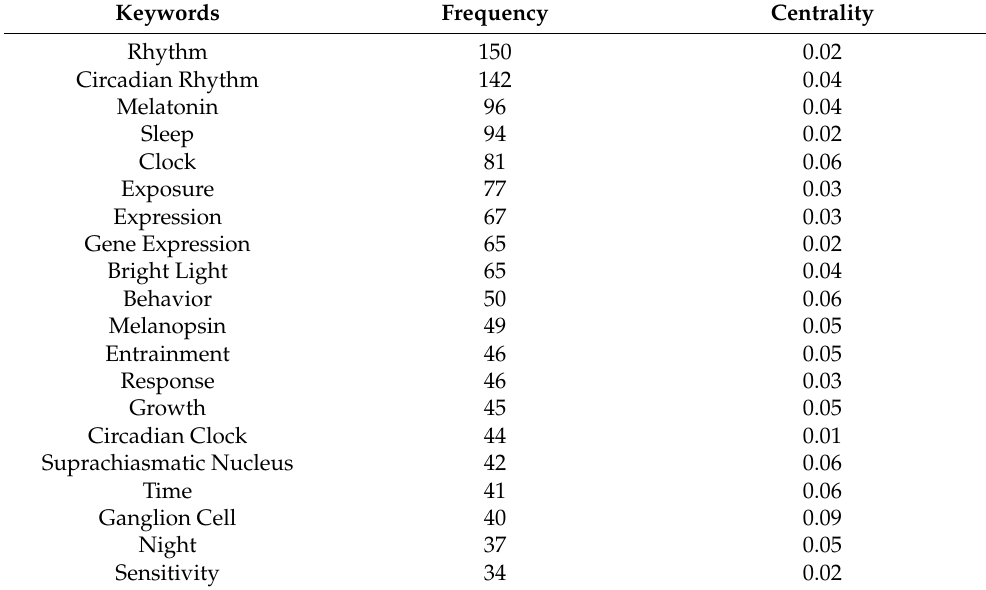
Table 1. Top 20 bodies by the frequency of appearance.